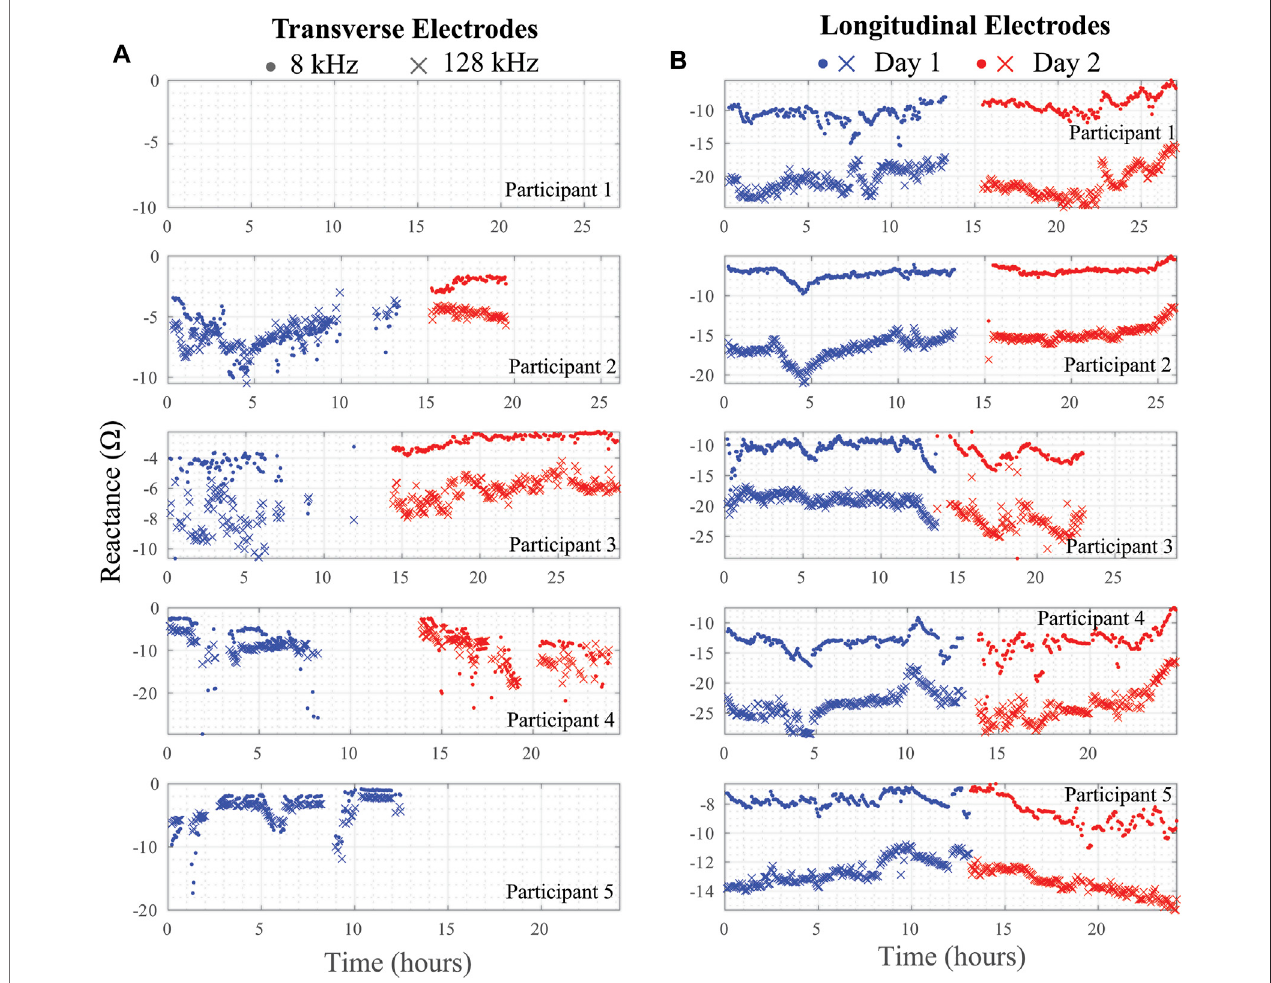
FIGURE 8 | (A) Transverse and (B) longitudinal knee tissue reactance (8 kHz, 128 kHz) collected during free-living across 2 days from 5 healthy adult participants using wearable sensing system.